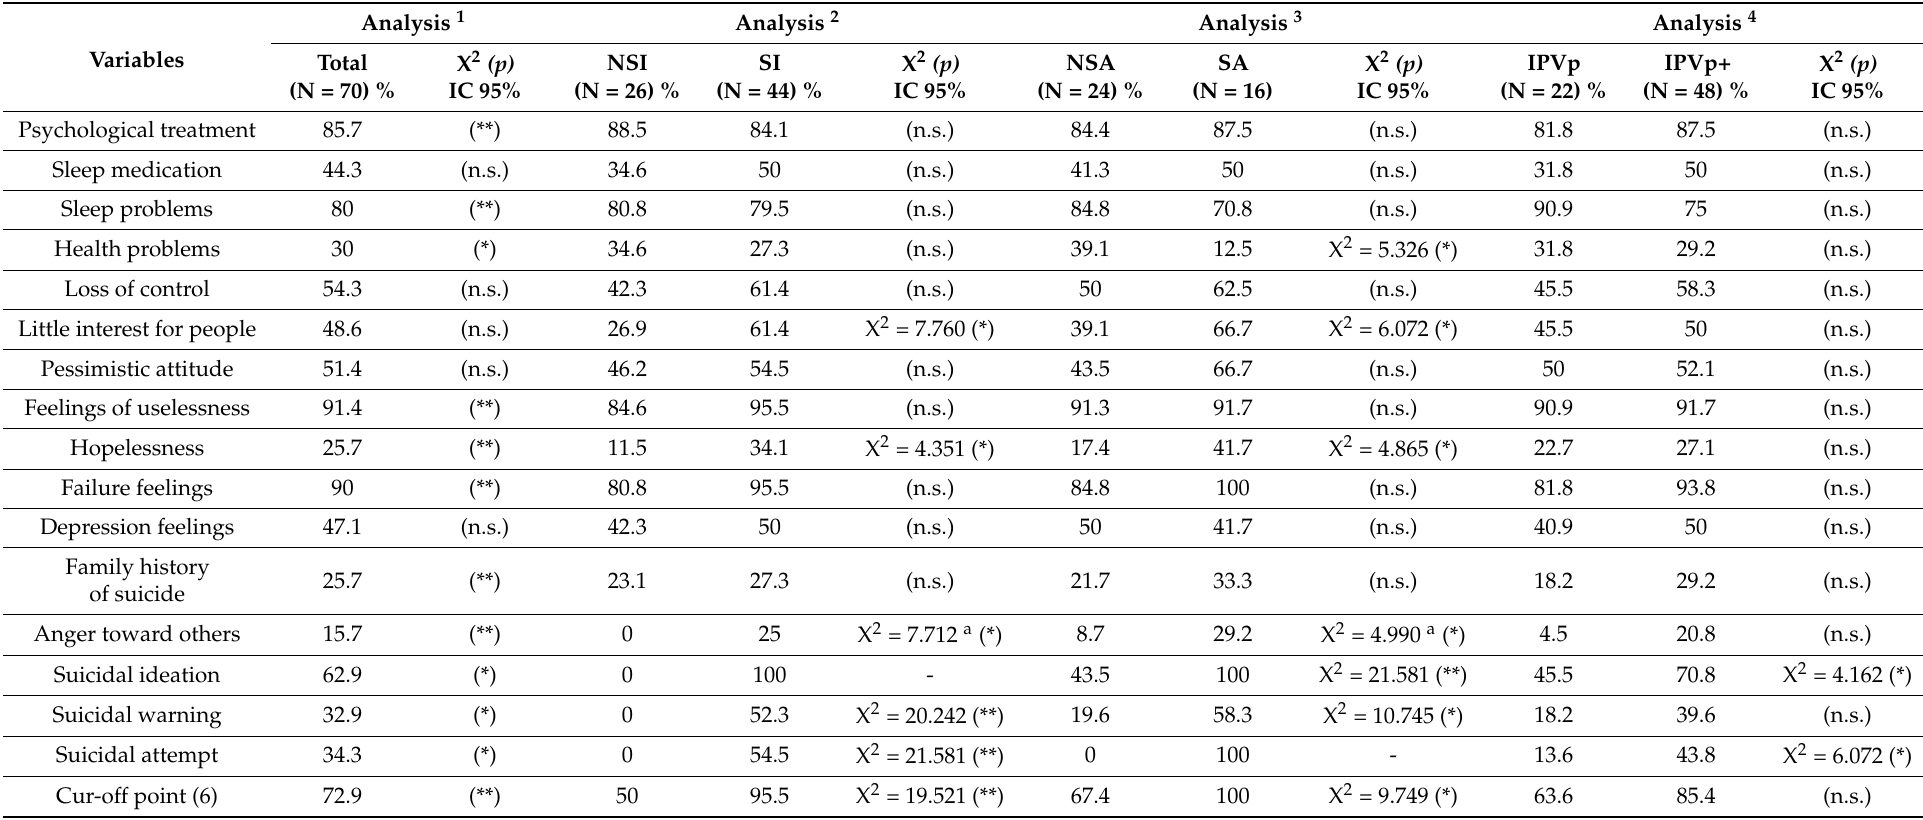
Table 3. Consequences of gender abuse according to suicidal behaviour and types of